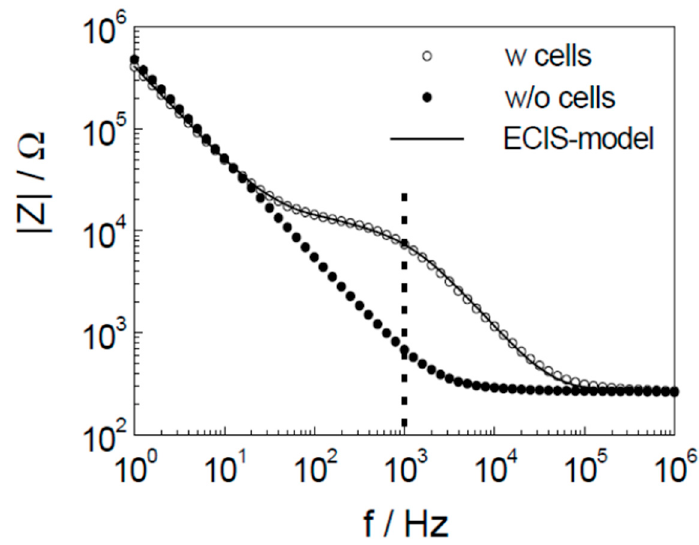
Figure 5. CBI spectra with and without cells performed on a gold electrode verifying that frequencies outside of 10 Hz–100 kHz were independent of cell properties. Reprinted from Arndt et al. [45] with permission from Elsevier.